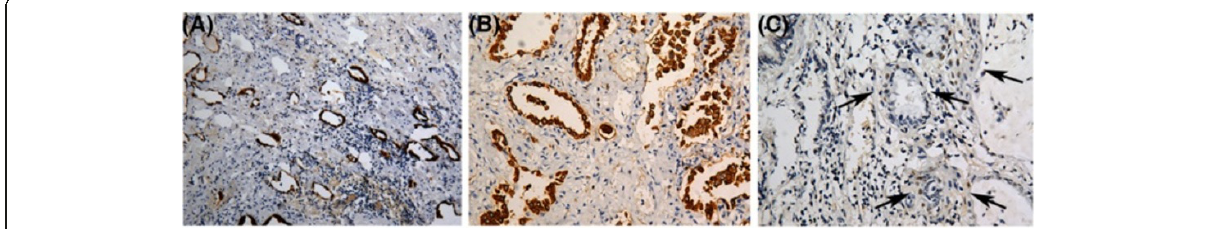
Figure 5 A-C Immunohistochemical staining of cytokeratin(AE1/AE3), SP-A and P53 protein. The tissue obtained from upper lobe of right lung. Cytokeratin was positive in residual alveolar epithelium of fibrosis tissue ( A , EnVision × 100).The strongly positive expression of SP-A is observed in hyperplastic type II alveolar epithelium ( B , EnVision×200), and some hyperplastic alveolar epithelium demonstrated positive expression of P53 ( C , arrow. EnVision ×